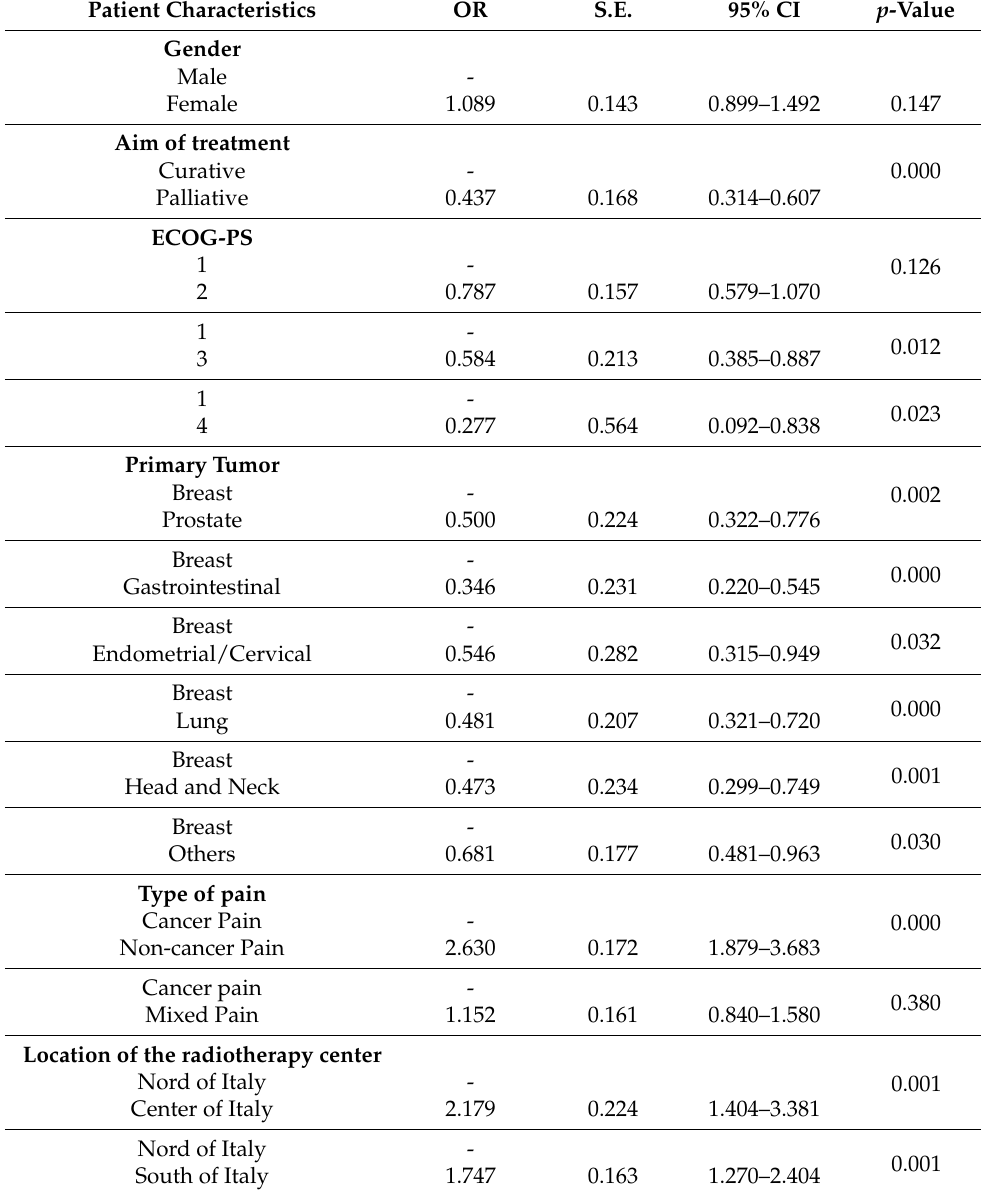
Table 3. Multivariable analysis (only 1417 patients with pain or under analgesic therapy